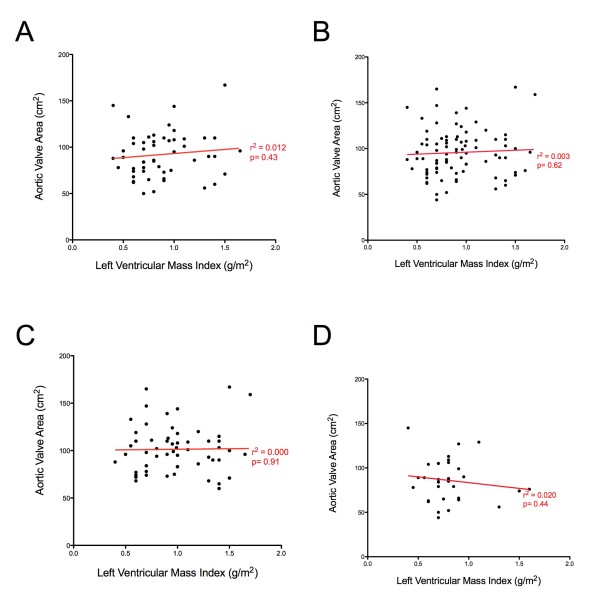
 Lack of correlation between aortic valve area and left ventricular mass index.A. Total population. B. Population after excluding patients with hypertension. C. Males. D. Females.